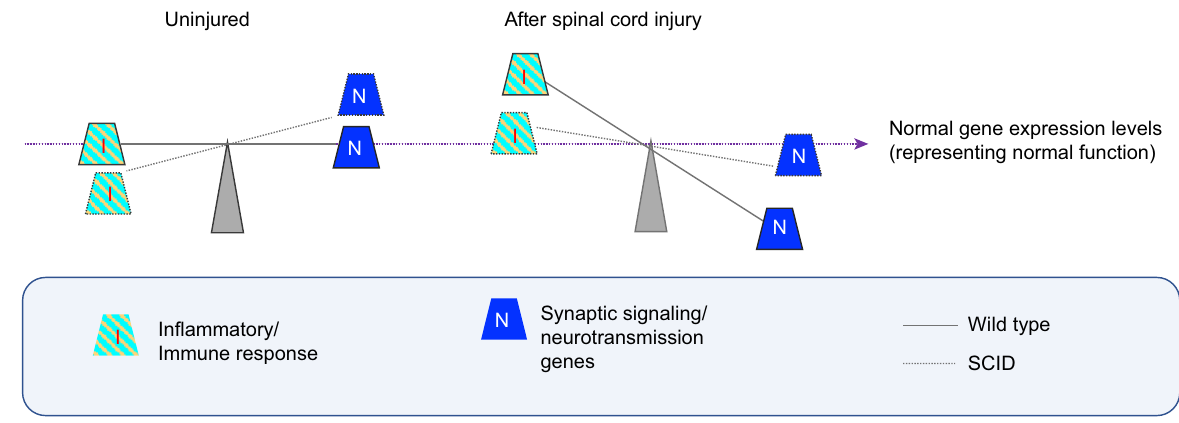
Figure 7. Current working model delineating the seesaw relationship between neurotransmission program and immune function. As demonstrated, synapse/neurotransmission-related gene expression program can be in fl uenced by immune functional gene expression, and an appropriate (i.e., neither too high nor too low) expression levels of synapse/neurotransmission module genes are critical for proper neuronal